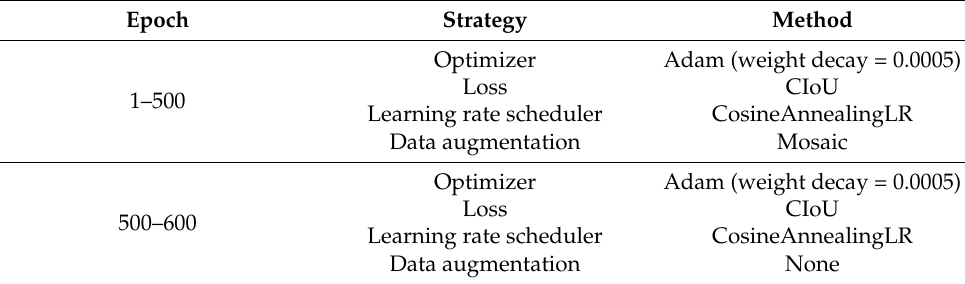
Table 2. Strategy for two-stage model